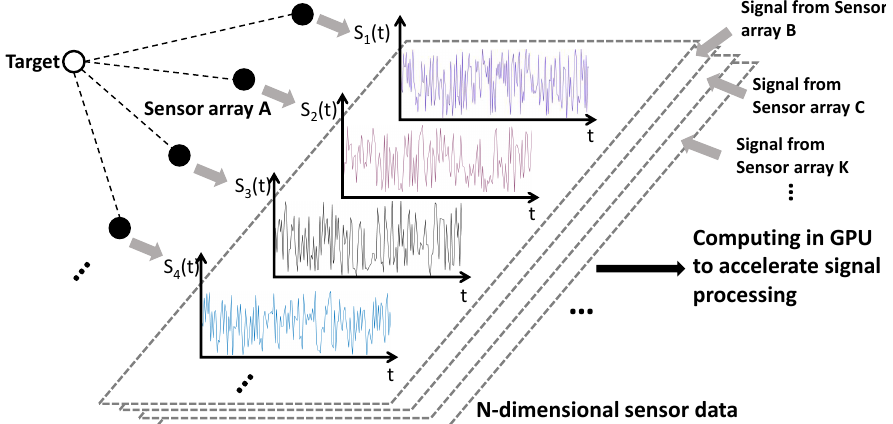
Figure 2. Accelerated signal processing for large amounts of data using